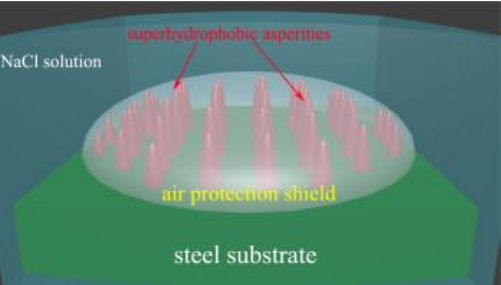
Figure 15. Representation of the anti-corrosion mechanism of superhydrophobic membranes in corrosive solution medium. Reproduced with permission from [111].